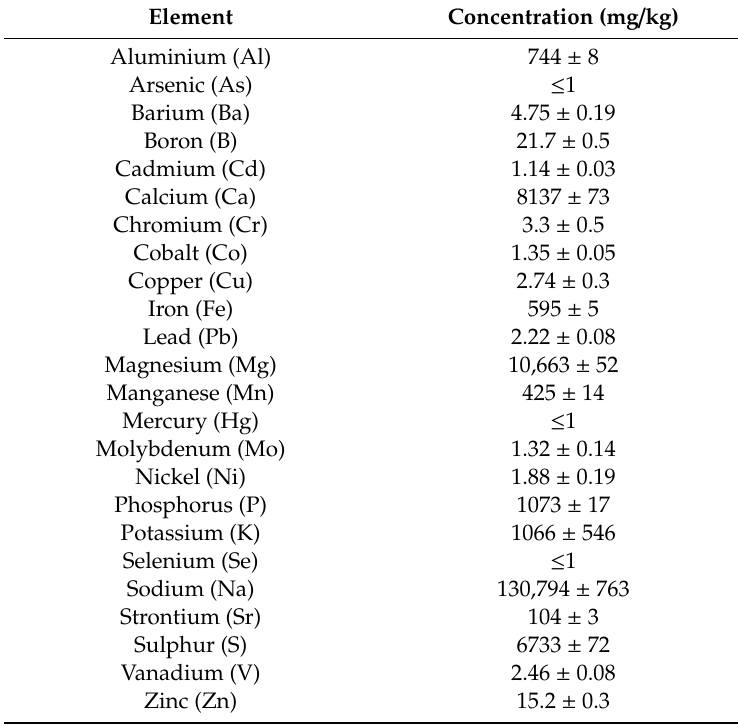
Table 1. Elemental composition of dried Caulerpa lentillifera